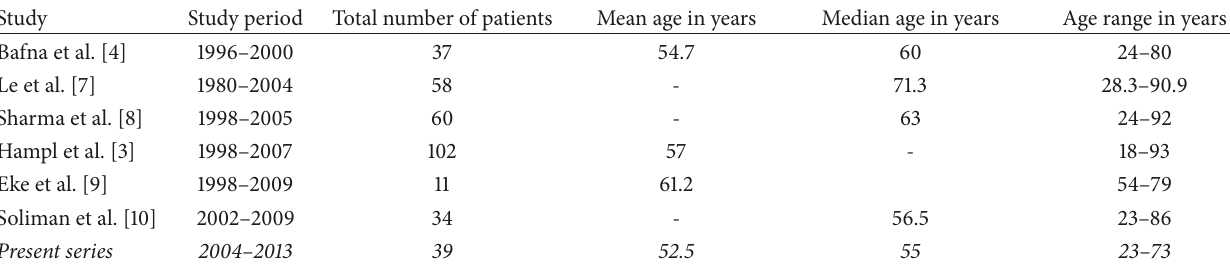
Table 3: Mean and Median age of the patients in different series.